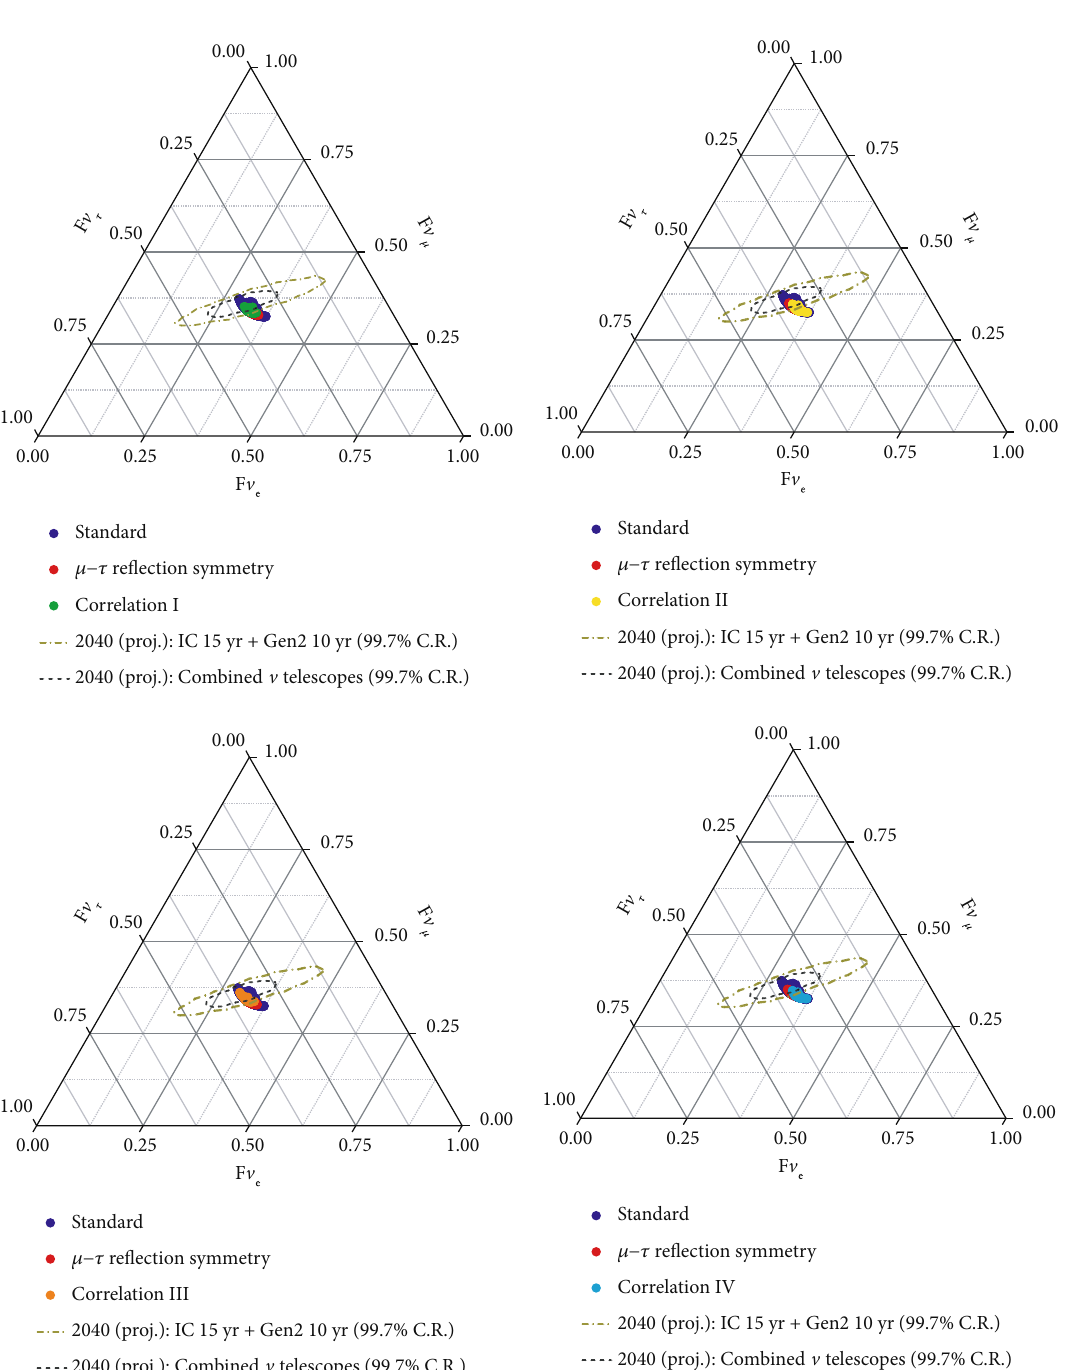
Figure 12: Ternary plot of the fl avor ratio at Earth with the pion-decay source based on the geometric constraints of the correlations I-IV. The conventions of parameters and colors are the same as those in Figure